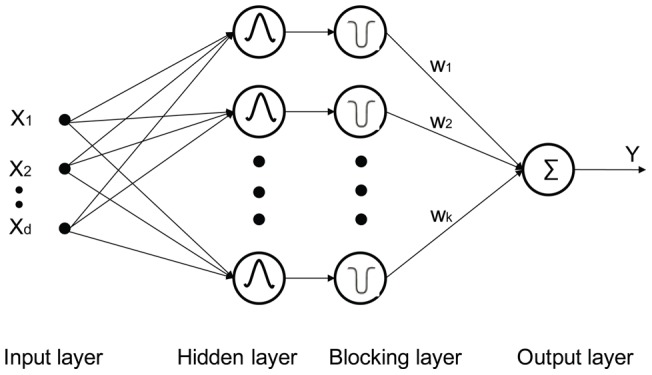
MSRBF architecture.